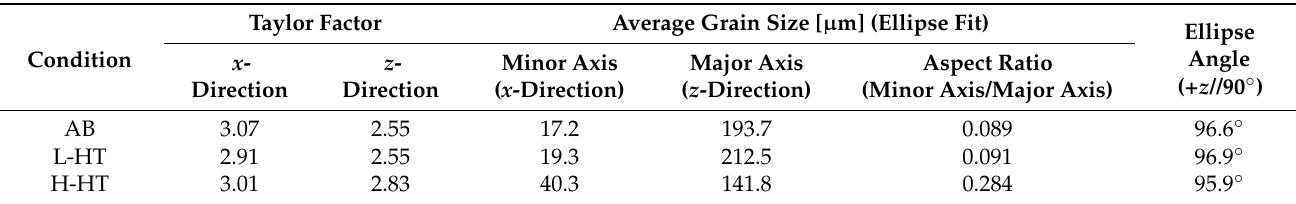
Figure 5. Summary of tensile properties. Heat treatment conditions, tensile direction, and test temperature were varied. The typical values of IN738LC castings [39] are also shown. Table 3. Taylor factor and average grain size before and after heat treatments.